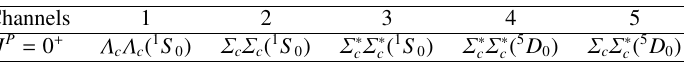
Table 2. The S -wave Λ c Λ c state and the channels which couple to